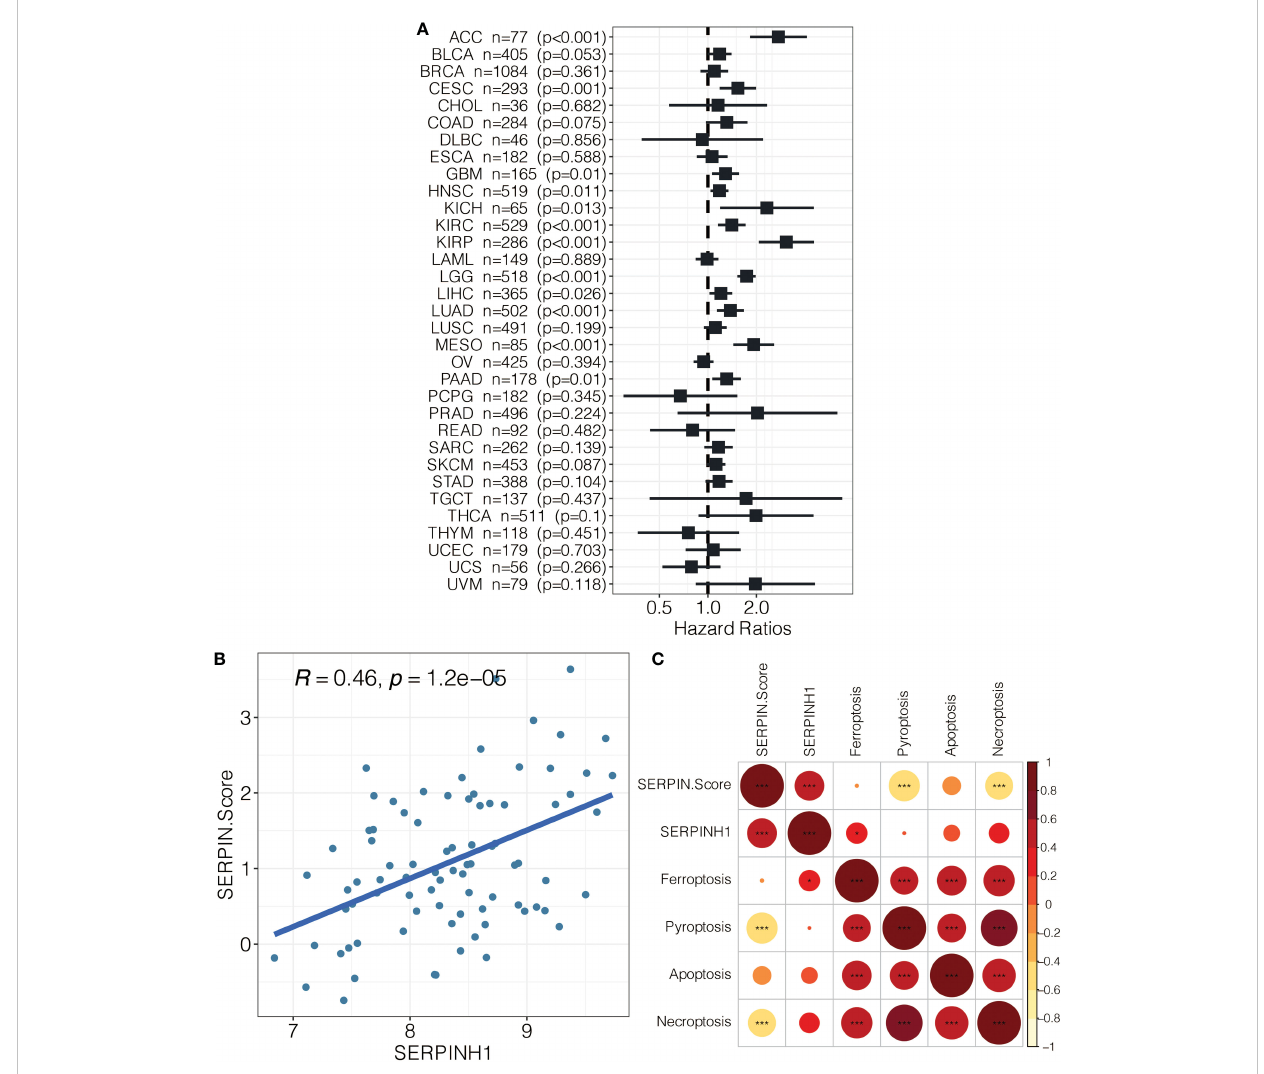
FIGURE 9 (A) Pan-cancer analysis on SERPINH1. (B) The correlation between SERPINH1 and SERPINH1-related score. (C) The correlation between SERPINH1, SERPINH1-related score, ferroptosis, pyroptosis, apoptosis, and